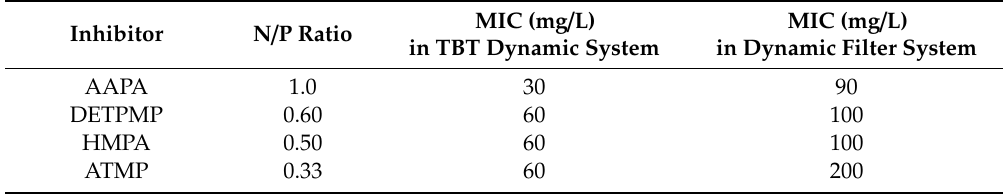
Figure 6. Dynamic e ffi ciency of 7 µ m filter scale (naphthenate flow rig) using naphthenic acid extract or pure heptane solvent in the organic phase with addition of scale inhibitor ATMP in anions brine at 80 ◦ C and 44 psi. O.P.—organic phase; A.P.—aqueous phase. Table 3. MIC for calcium carbonate using conventional TBT dynamic system and dynamic sintered metal filter system at 80 ◦ C and 44